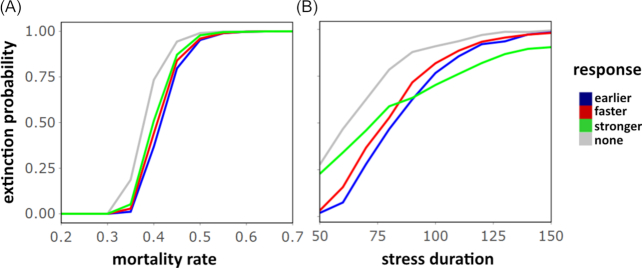
Extinction probability of a population following no or one of the three primed response strategies under (A) different stress intensities with stress duration \documentclass[12pt]{minimal}
\usepackage{amsmath}
\usepackage{wasysym}
\usepackage{amsfonts}
\usepackage{amssymb}
\usepackage{amsbsy}
\usepackage{upgreek}
\usepackage{mathrsfs}
\setlength{\oddsidemargin}{-69pt}
\begin{document}
}{}$\mathrm{ TD}\ = \ 75\ $\end{document} or (B) different stress durations with stress intensity \documentclass[12pt]{minimal}
\usepackage{amsmath}
\usepackage{wasysym}
\usepackage{amsfonts}
\usepackage{amssymb}
\usepackage{amsbsy}
\usepackage{upgreek}
\usepackage{mathrsfs}
\setlength{\oddsidemargin}{-69pt}
\begin{document}
}{}${m_\mathrm{ I}} = \ 0.4$\end{document}. The extinction probability is approximated by the fraction of 10 000 populations that did not survive until \documentclass[12pt]{minimal}
\usepackage{amsmath}
\usepackage{wasysym}
\usepackage{amsfonts}
\usepackage{amssymb}
\usepackage{amsbsy}
\usepackage{upgreek}
\usepackage{mathrsfs}
\setlength{\oddsidemargin}{-69pt}
\begin{document}
}{}${t_{\mathrm{ SE}}}$\end{document} (end of stress).